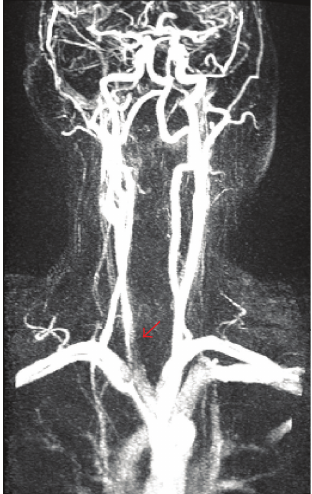
Figure 7: Known dissection Stanford type A with transmitted dissection membrane in brachiocephalic artery, subclavian artery on both sides, and left